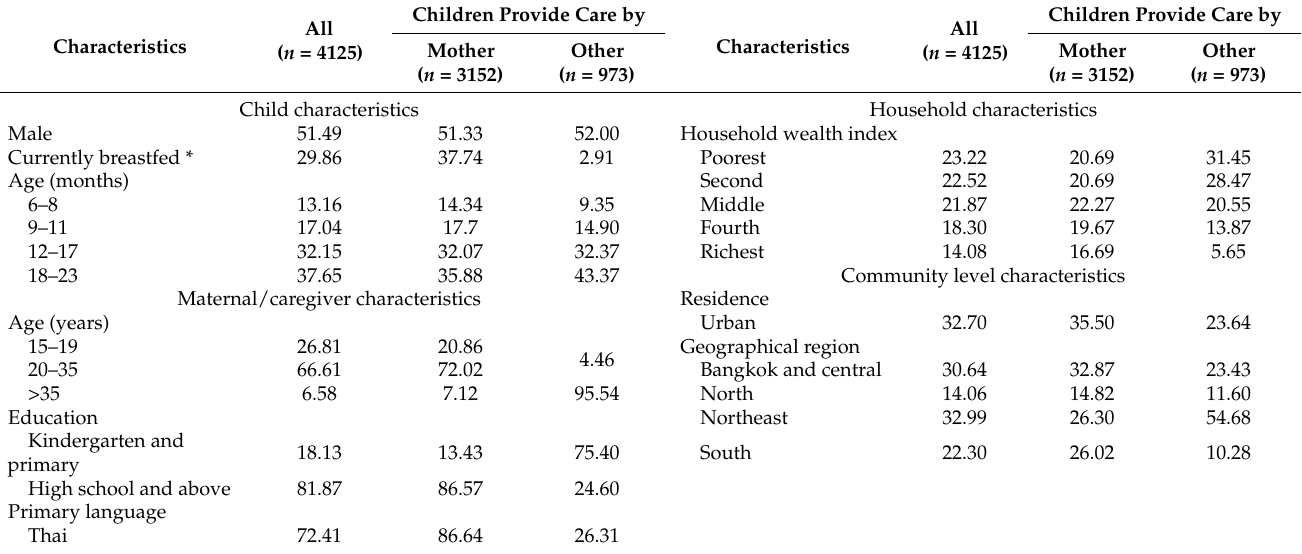
Table 2. Percentage of individual-, caregiver-, household-, and community-level characteristics of children aged 6–23 months, Thailand 2019 ( n =